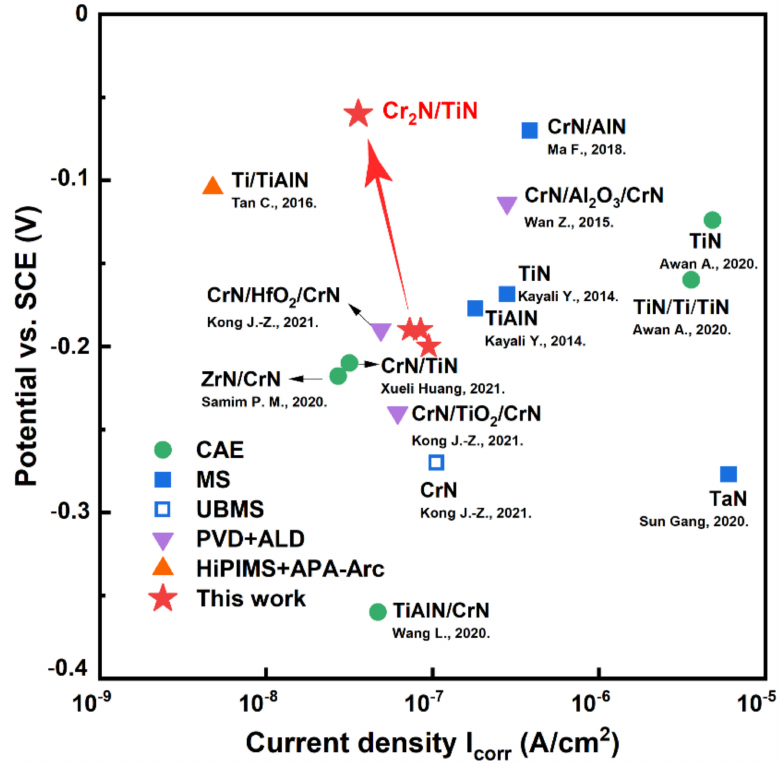
Figure 14. The investigation on corrosion resistance of different coating systems